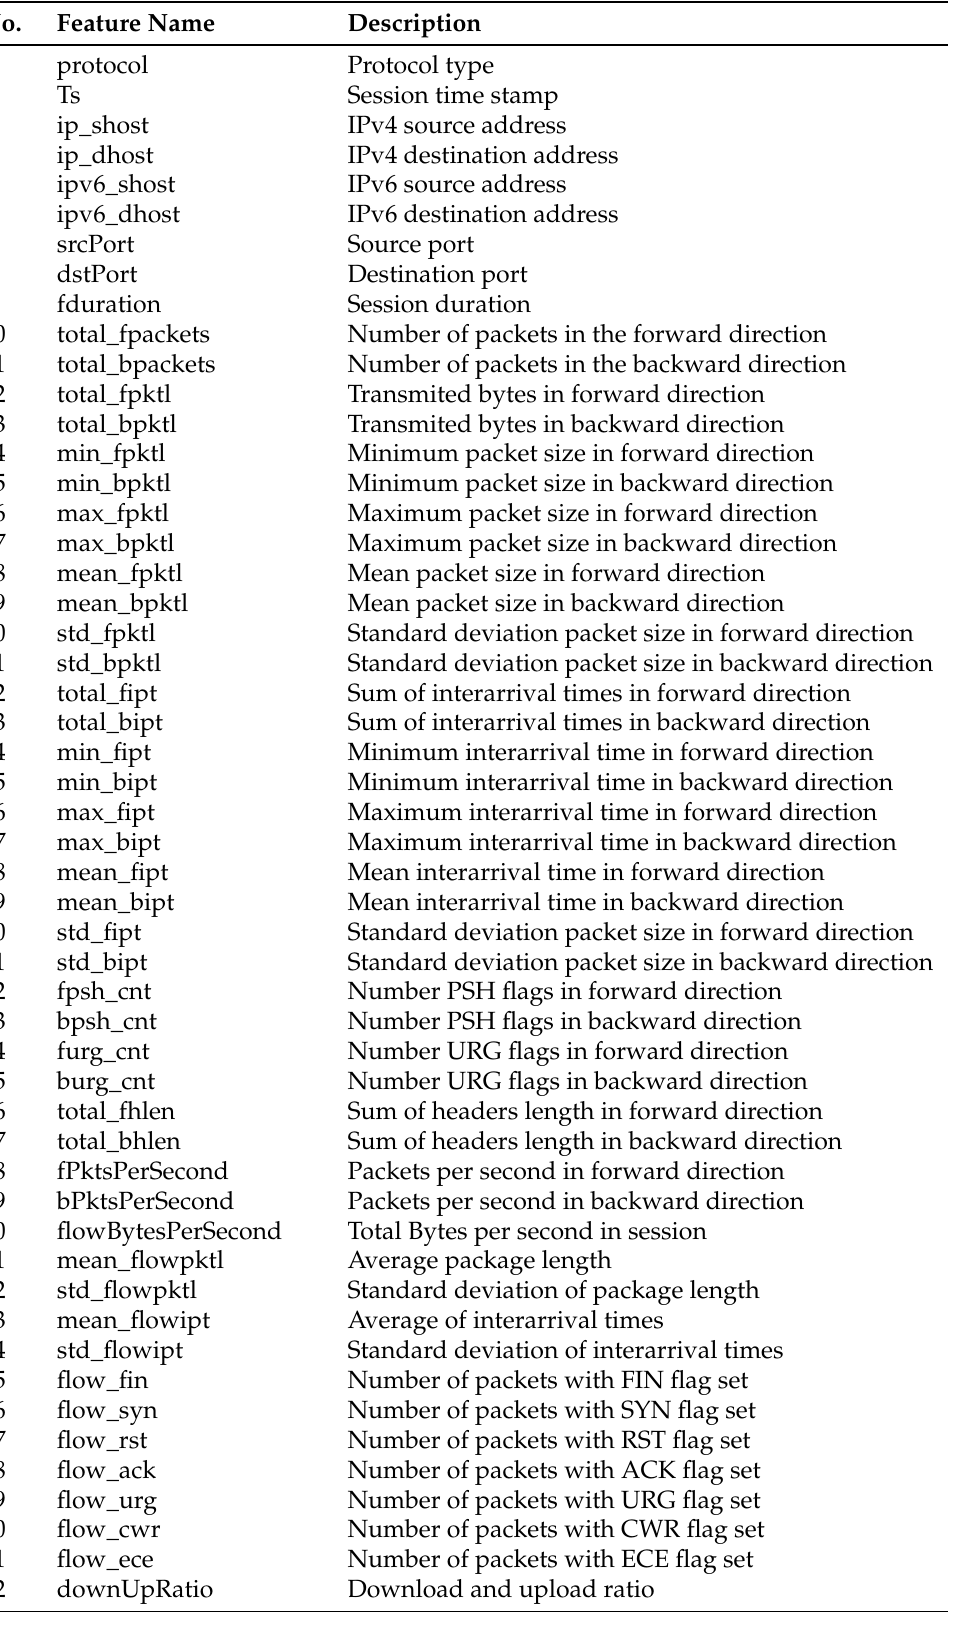
Table 4. Network sessions proposed